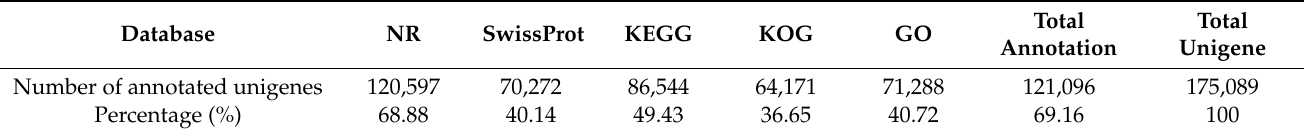
Table 3. Summary of annotations on the unigenes in the D. loddigesii transcriptome against pub- lic